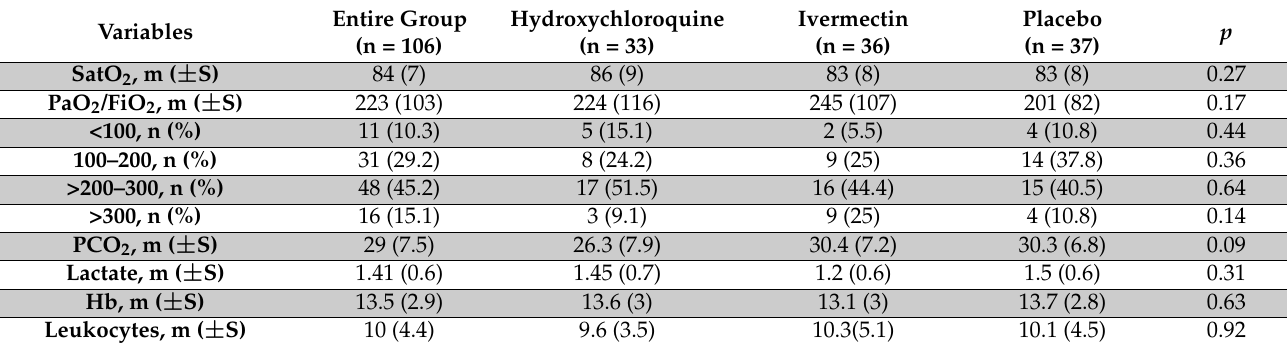
Table 3. Biochemical and gasometric